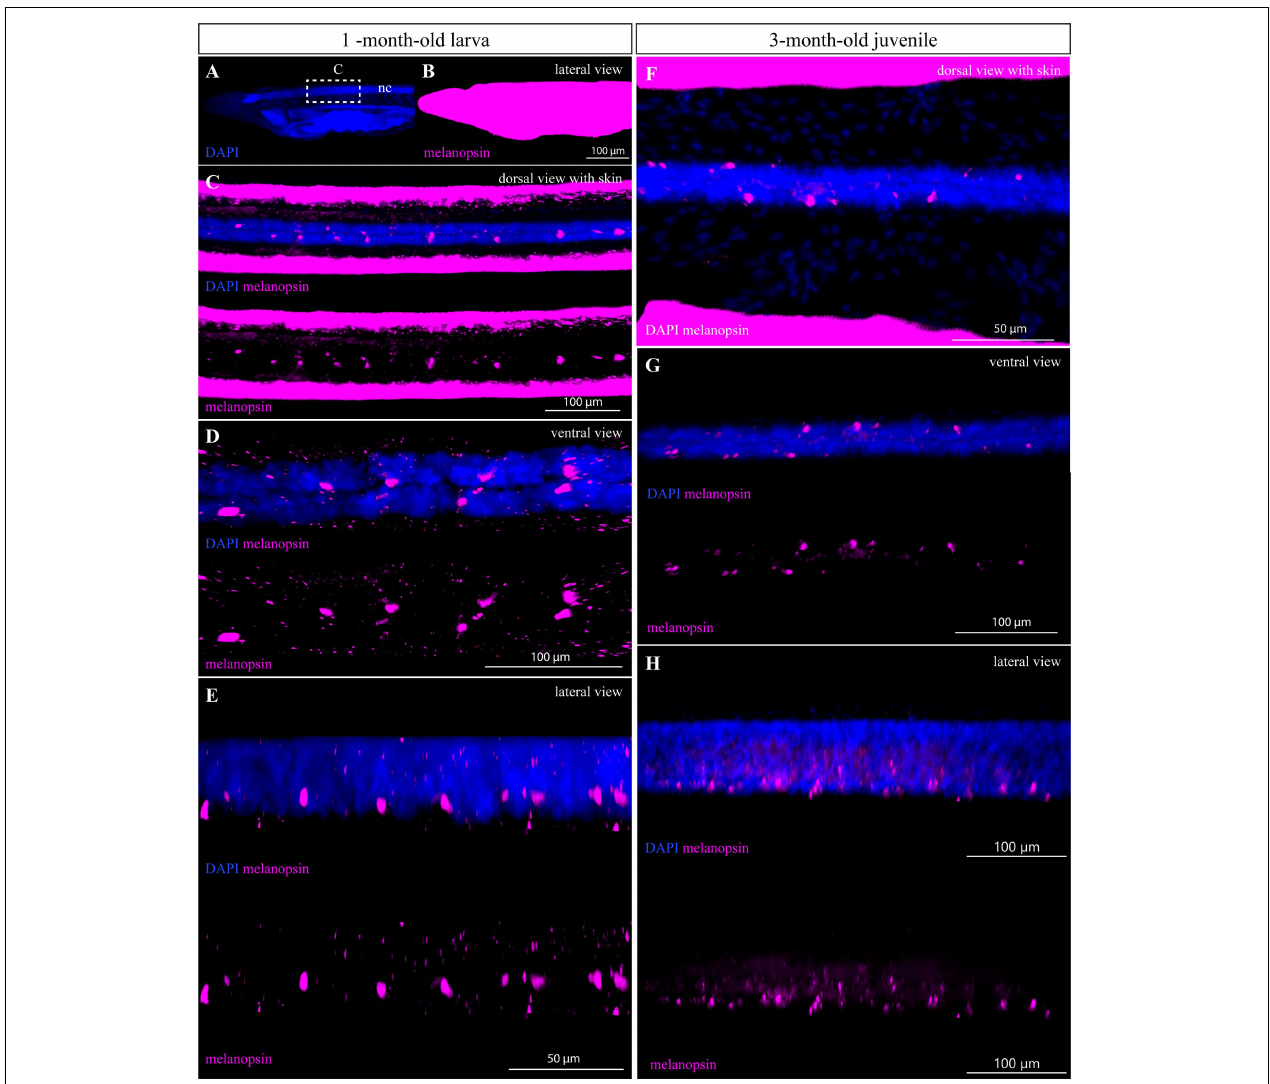
FIGURE 5 | IHC staining of melanopsin in 1- and 3-month-old amphioxus specimens. (A,B) Whole mount of the anterior part of 1-month-old larva shown with the adjustment of brightness/contrast required to visualize the signal of melanopsin in the neural tube (C–E) . Dotted rectangle marks the region from which the neural tube was cropped by processing in IMARIS analysis software shown in (C–E) . (C) Subset of horizontal slices containing ventral neural cord with melanopsin-positive cells. (D) Subset of horizontal slices containing neural cord and melanopsin-positive cells after removal of optical slices containing skin tissue by the processing software. (E) Cropped area containing the neural cord with melanopsin-positive cells (with and without DAPI staining) from the lateral view. (F) Subset of horizontal slices with the neural tube of a 3-month-old juvenile stained with DAPI and melanopsin antibody. (G) Subset of horizontal slices containing the neural cord and melanopsin-positive cells after optical removal of skin tissue, from the dorsal view. (H) Detail of neural cord with melanopsin-positive cells (with and without DAPI staining) after removal of optical slices containing overstained skin tissue, from the lateral view. The specimens were imaged sequentially in the track switch